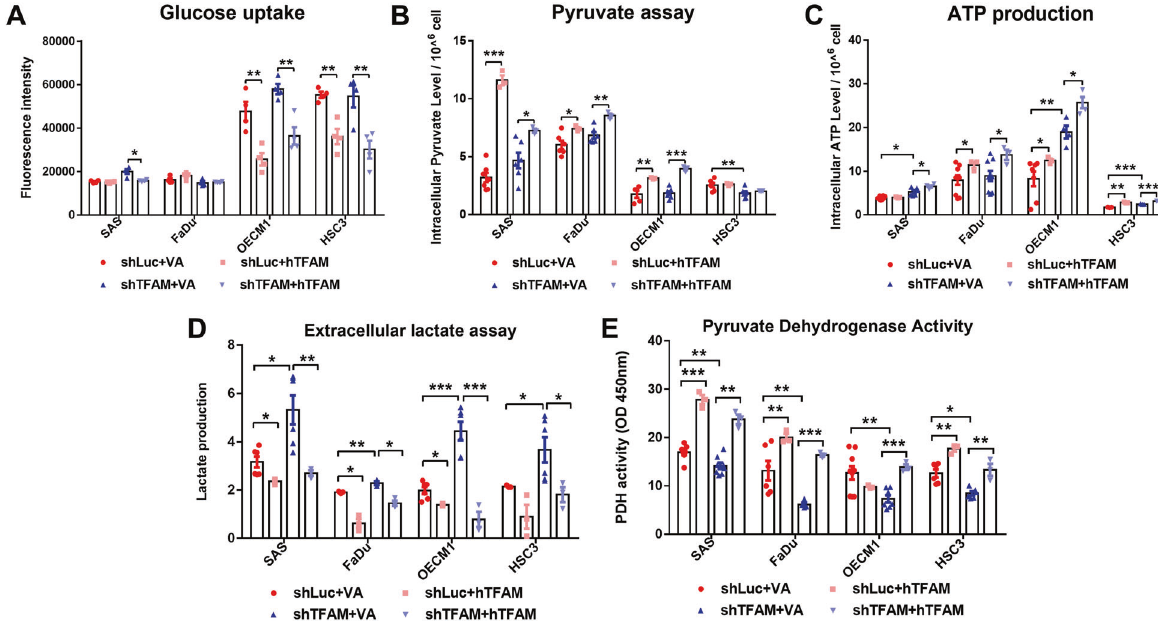
Fig. 3 TFAM silencing elicits metabolic reprogramming in HNC cells. No signi fi cant changes of ( A ) Glucose uptake, ( B ) Intracellular pyruvate and ( C ) ATP levels were found in TFAM-silenced HNC cells compared with control cells. In contrast, hTFAM overexpression dominantly modulated these metabolic indices in both shLuc and shTFAM transfected HNC cells compared with control (VA) transfectants. D Signi fi cant increasing extracellular lactate levels and ( E ) decreasing Pyruvate Dehydrogenase activity were detected in most TFAM -silenced HNC cells. Introduction of hTFAM largely reversed these metabolic states in both shLuc and shTFAM transfected HNC cells compared with VA transfectants. Data are presented as Mean ± SEM. Each dot ( N ≥ 3) in bar graph represents an individual biological replicate. VA Vector alone, hTFAM Full-length wild-type human TFAM. * p < 0.05, ** p < 0.01, *** p <